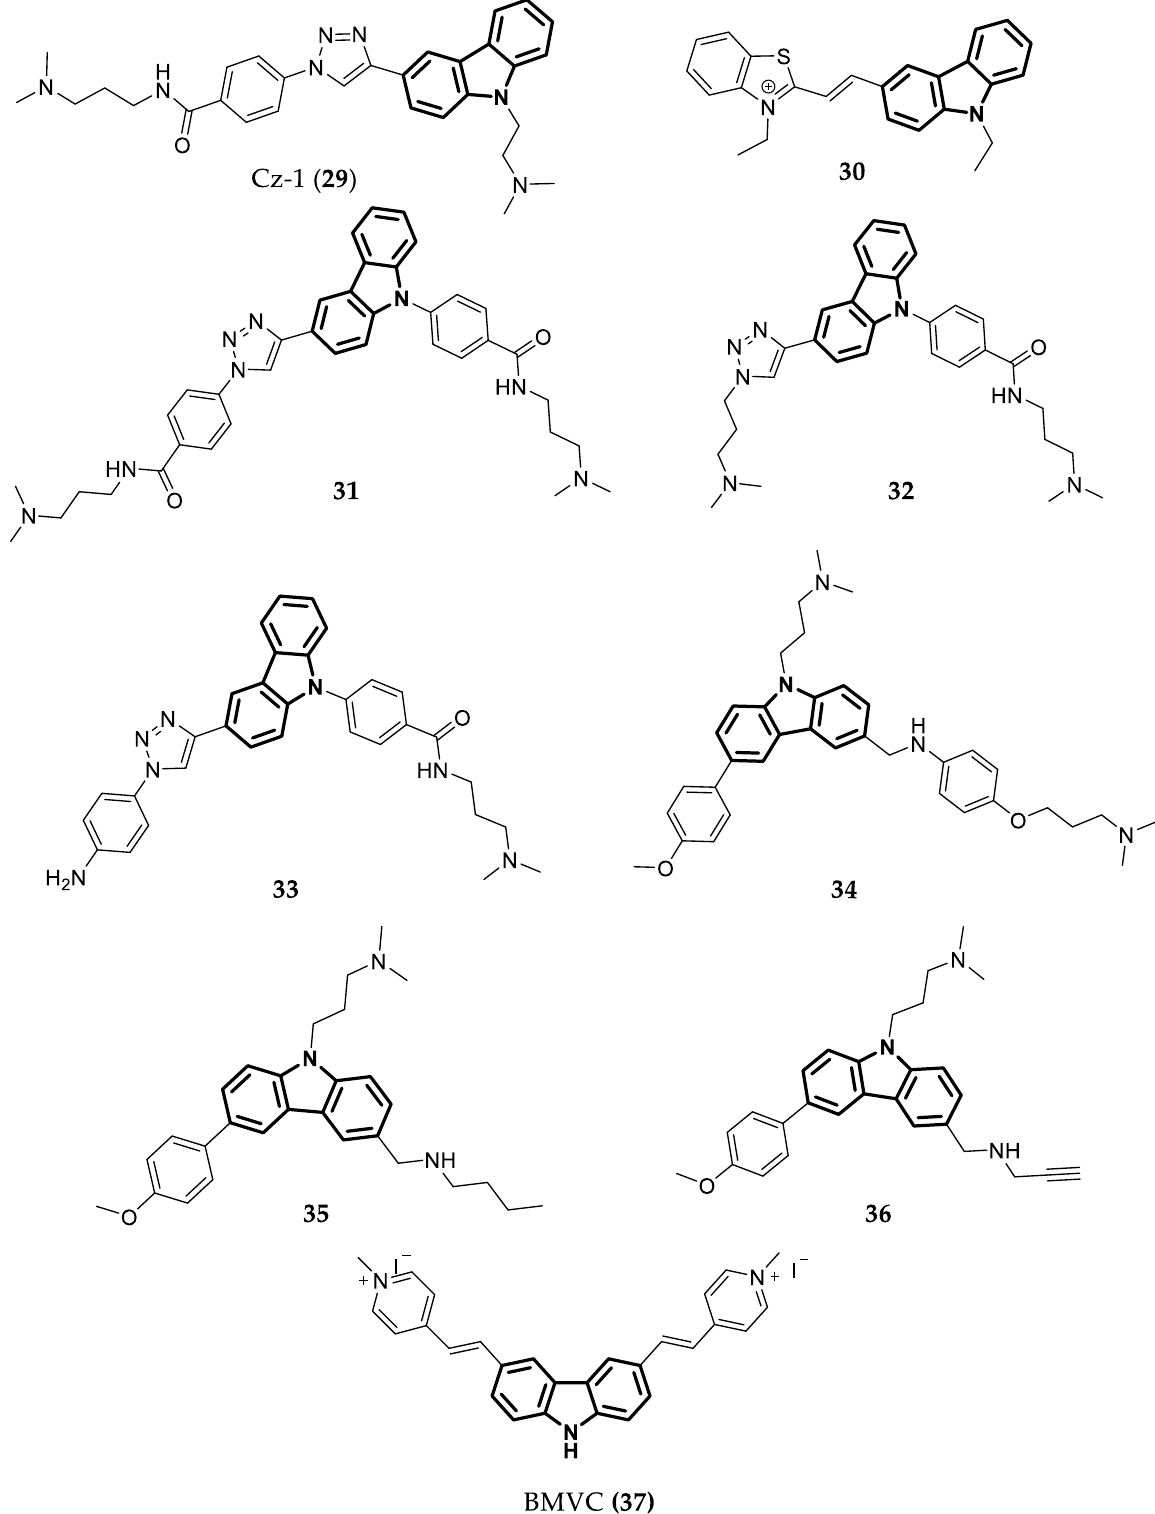
Figure 9. Structure of Carbazoles showing cancer cell antiproliferative activity and high capacity to stabilize c-MYC G4.